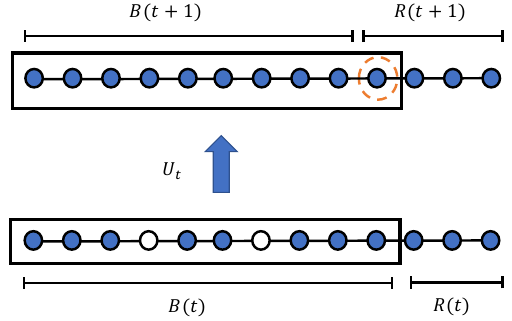
Figure 7 . A typical process in the chaotic evolution is one in which operators with non-trivial support somewhere in B ( t ) evolve to operators with non-trivial support at all sites in B ( t ) . for A = R ( t ) would be from the identity operator in the initial density matrix, and one would have only the first term in (2.14), leading to indefinite growth of S ( R ( t )) past the Page